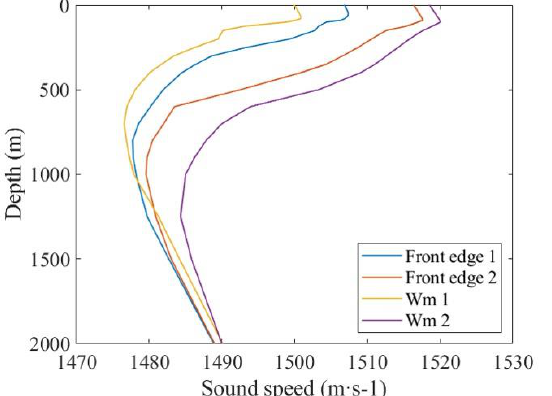
Figure 7. Sound speed profiles of water masses on both sides of the frontal zone (Wm 1 and Wm 2, representing (38 ◦ N, 144 ◦ E) and (36 ◦ N, 144 ◦ E)) and on the edge of the frontal zone (Front edge 1 and Front edge 2) (0 – 2000 m, 1 January 2019). There are obvious differences between the sound speed profiles of water masses on both sides of the frontal zone. The depth of the SOFAR axis (the depth of the minimum sound speed) of the SSP on the north side was deeper. Between the front edge, 1 and 2 are the sound speed profiles in the frontal zone.